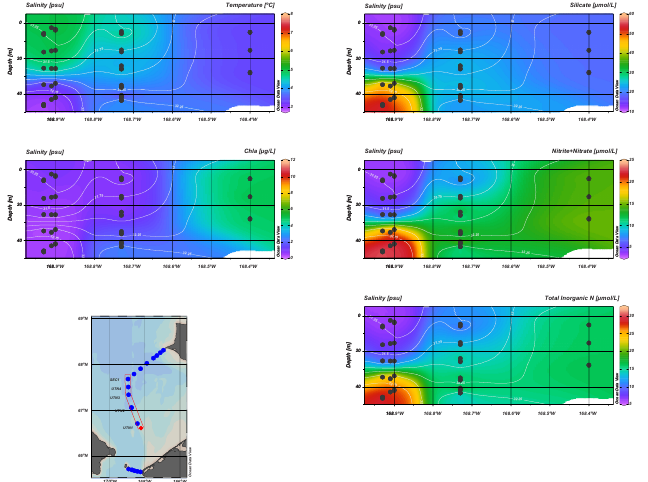
Figure 6. Distributions of water column properties on a southeast to northwest transect of the UTN stations that are part of DBO 3 from the October 2020 Norseman II cruise. Salinities are shown as white isolines and colors correspond to nutrient concentrations matching the color bars to the right.